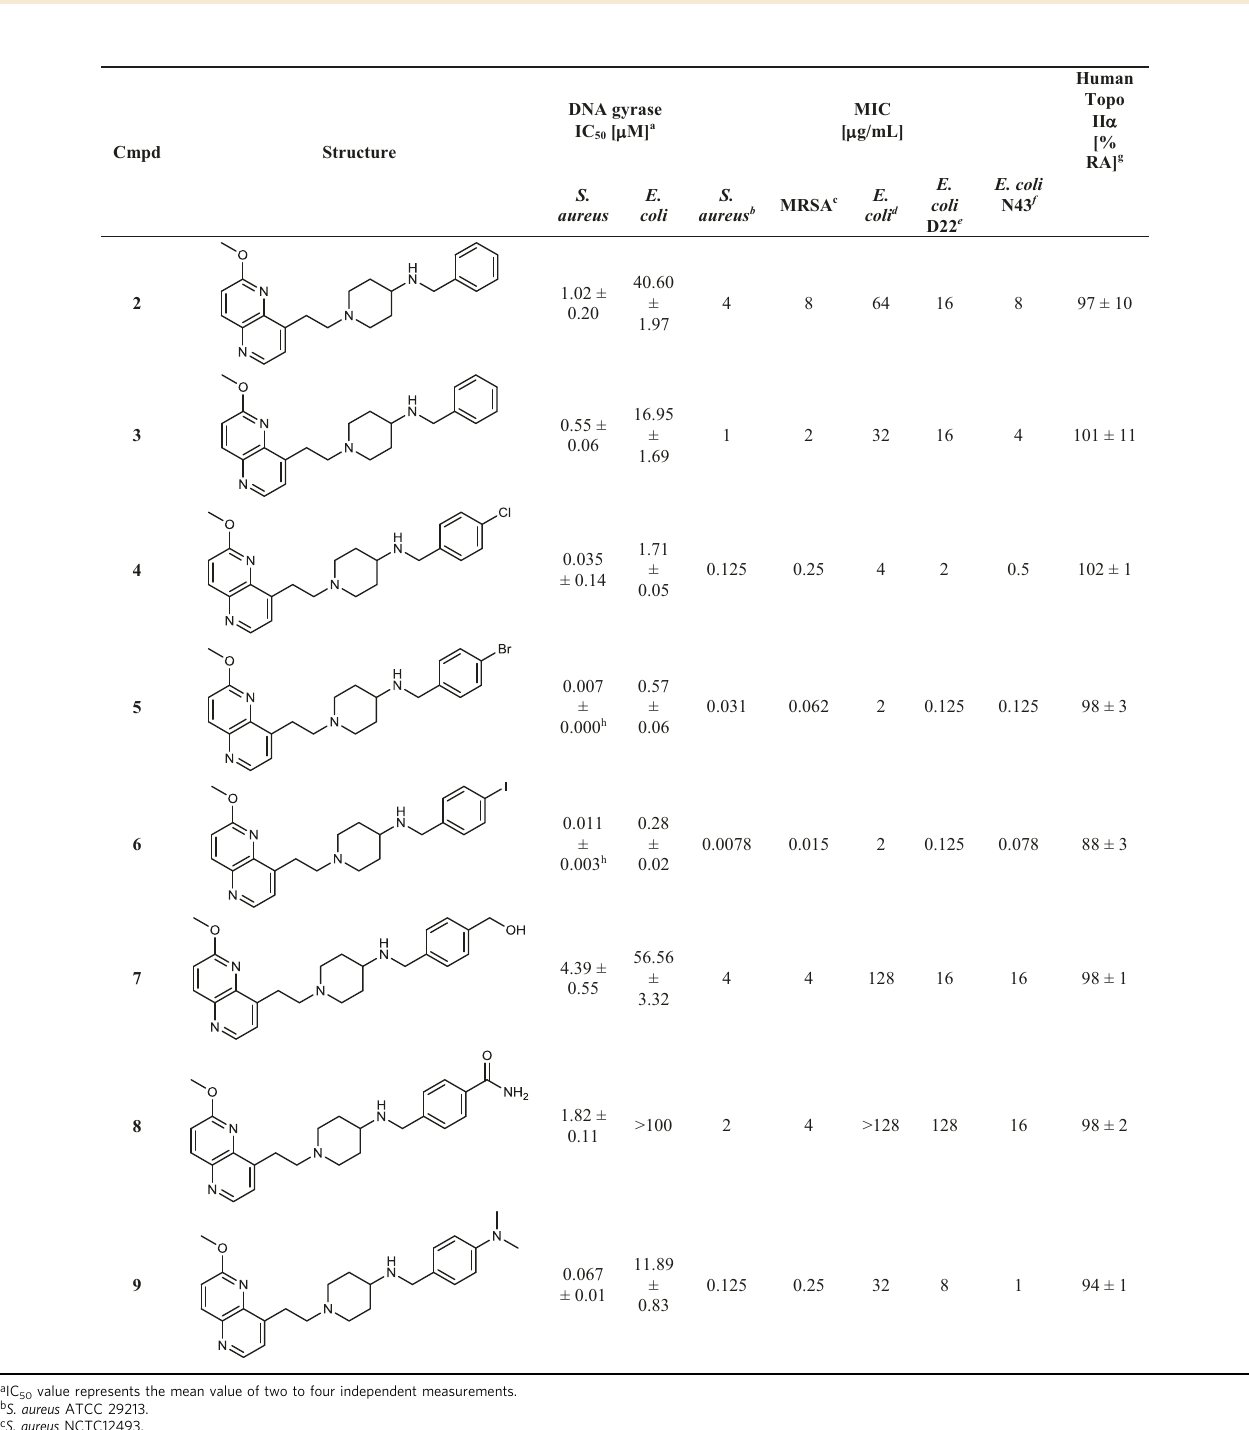
Table 1 DNA supercoiling inhibition of S. aureus and E. coli DNA gyrase and decatenation activity of human topoisomerase II α affected by